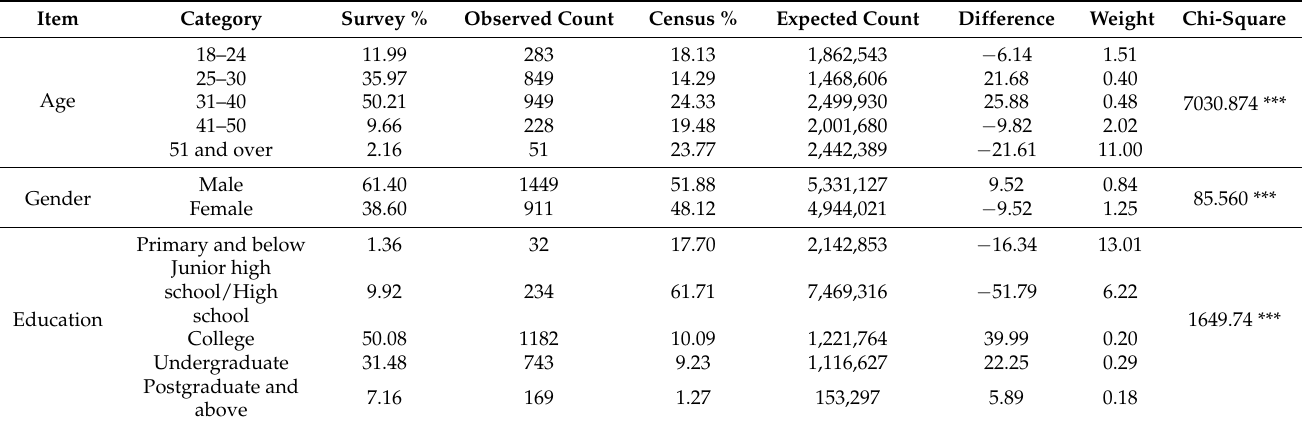
Table 2. Validation of the representatives of population samples compared to census data and weights for each population